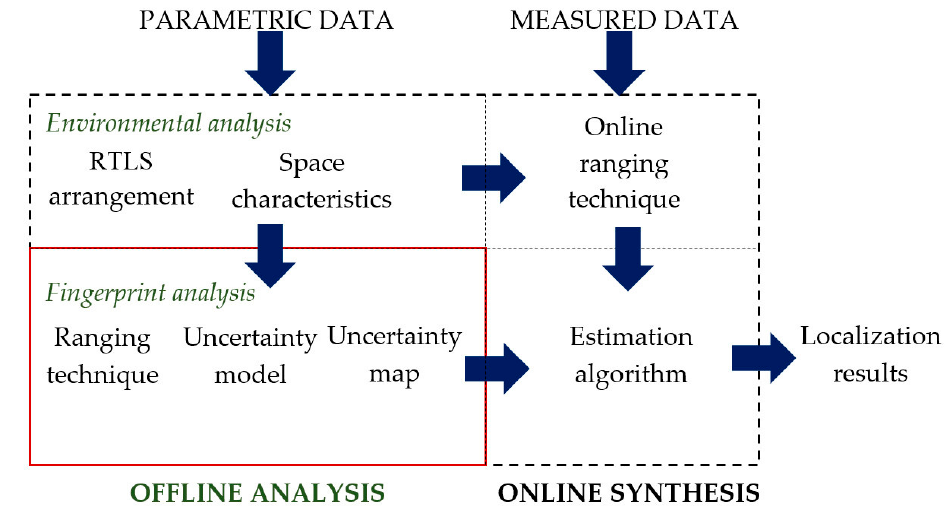
Figure 1. RTLS (Real-time Locating System) AoA (Angle of Arrival) fingerprinting method block diagram.